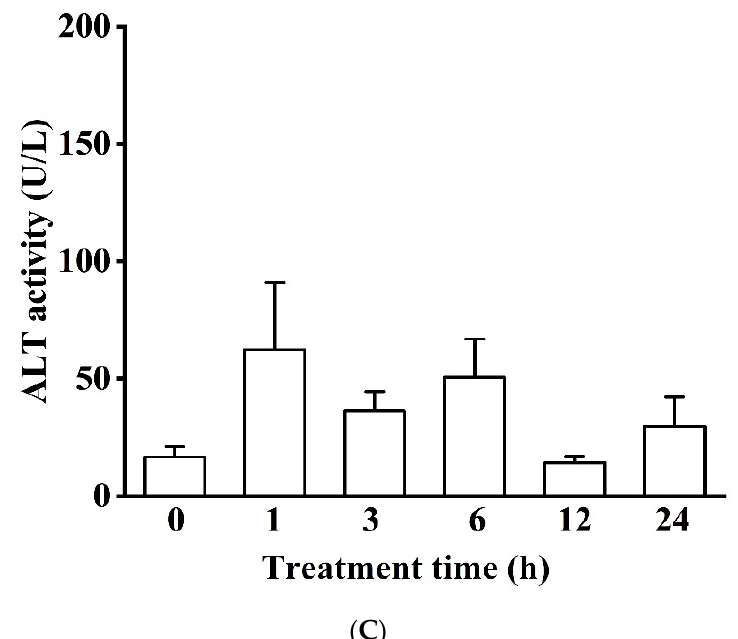
Figure 2. Effects of acute hypoxia on enzymatic activities of lactate dehydrogenase (LDH) ( A ), alkaline phosphatase (ALP) ( B ), and alanine aminotransferase (ALT) ( C ) in blood serum. Different letters indicate significant differences ( p < 0.05). There was no significant difference in ALT activity among the six treatment groups.